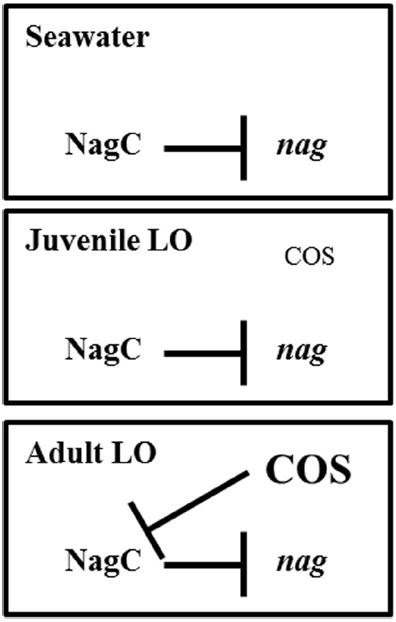
Model for NagC function in symbiosis. In nutrient poor conditions, including seawater, NagC represses gene expression. During initial colonization of the squid light organ, NagC continues to repress gene expression, despite the presence of a COS gradient that facilitates chemotaxis into the light organ pores (Mandel et al., 2012). Within the mature light organ, populations of V. fischeri use NagC to regulate gene expression in accordance with a diel rhythm involving COS (Wier et al., 2010; Schwartzman et al., 2015).